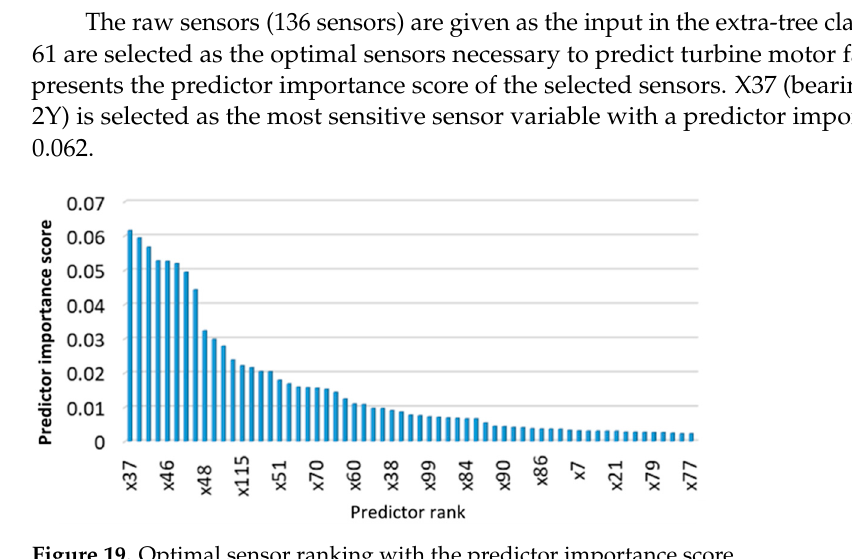
Figure 19. Optimal sensor ranking with the predictor importance score. Figure 20 lists the complete sensors selected by the extra-tree classifier according to the predictor rank.